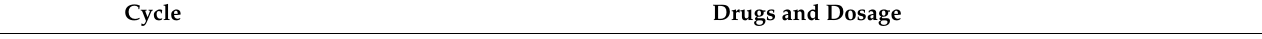
Table 1. Therapy courses according to AIEOP LNH-97 protocol for ALCL, risk group R3, with CNS involvement. Cycle Drugs and Dosage Prephase